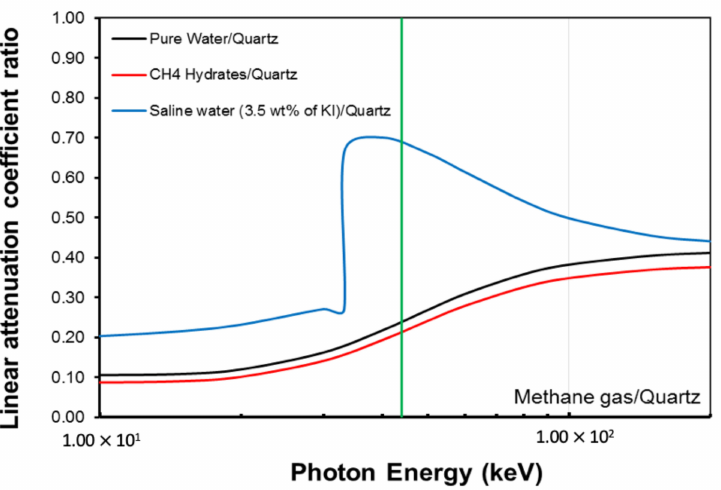
Figure 2. Linear attenuation coefficients relative to quartz vs. photon